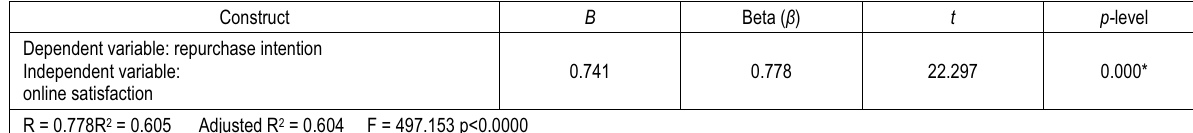
Table 8. Regression analysis: online satisfaction and repurchase intentions Construct B